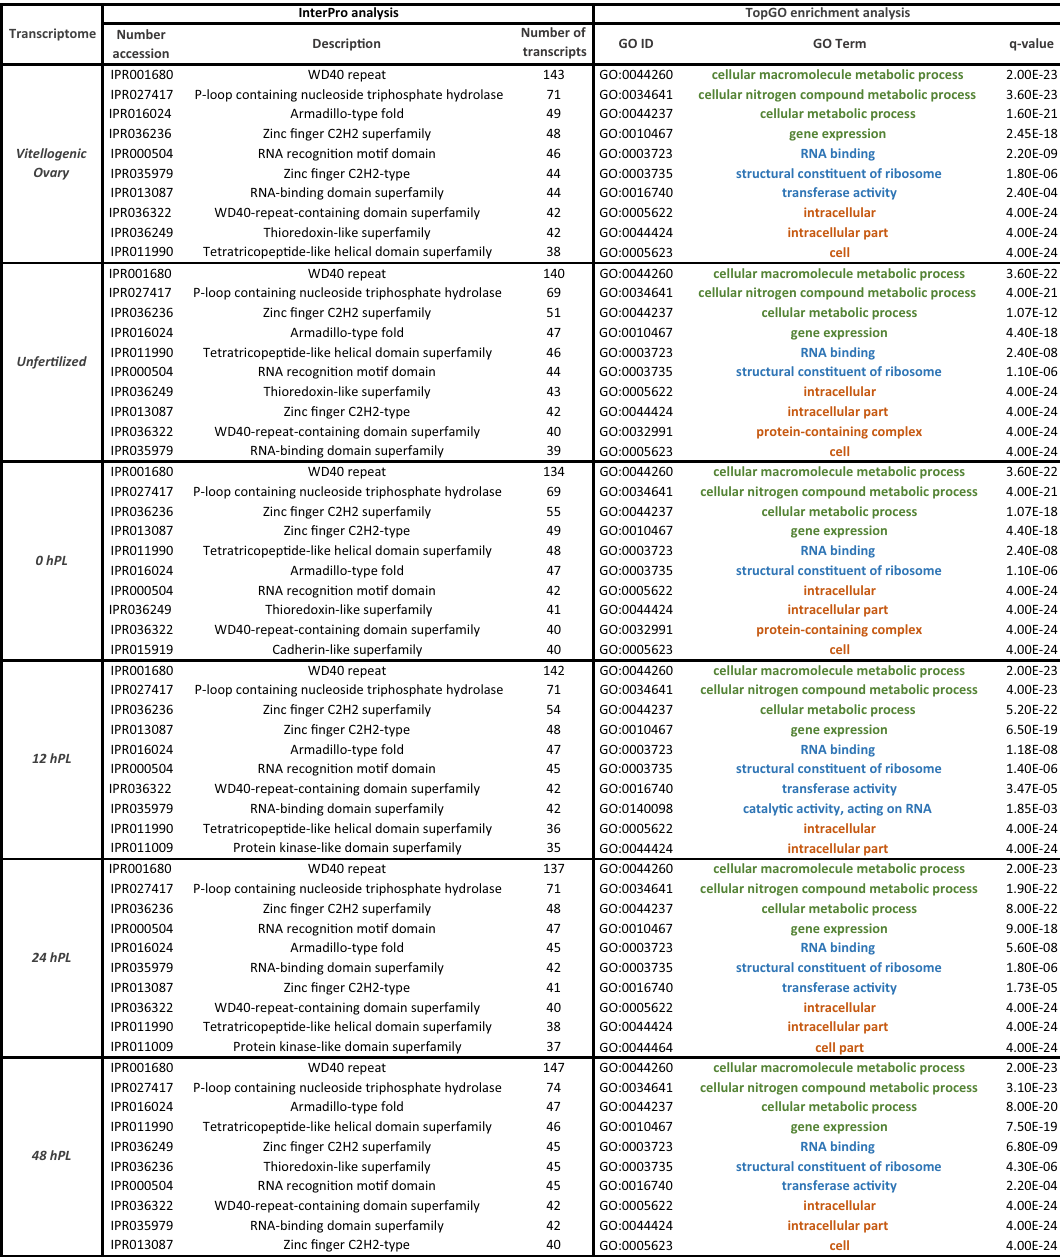
Table 2. Summary of the functional annotation. Top 10 Interpro domains and GO terms enriched in each transcriptome analyzed. TopGO results were shown in different colors according to the three sub-ontologies: green “Biological Process”, blue “Molecular Functions” and orange “Cellular